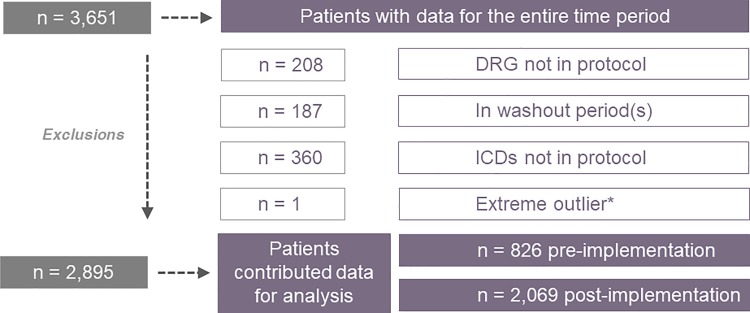
Patient attrition. *Admission time to OR time assumed to be erroneous (>1000 days). DRG indicates diagnosis-related group; ICD, international classification of disease; OR, operating room.